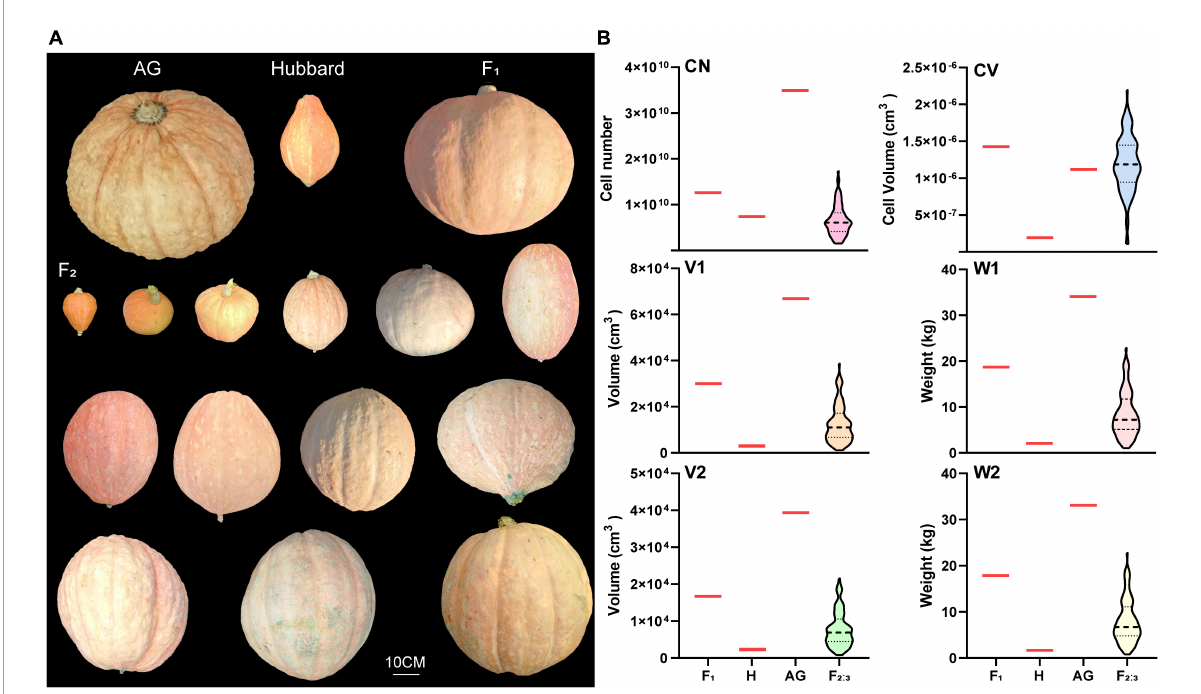
FIGURE1 Fruit phenotypic characterization of two parents “Atlantic Giant” and “Hubbard”, the F 1 hybrid and the F 2 : 3 groups. (A) Fruit morphology. (B) Violin plots of cell number (CN), cell volume (CV), fruit volume (V1), fruit weight (W1), fruit volume without seeds and placenta (V2) and fruit weight without seeds and placenta (W2) of Atlantic Giant (AG), Hubbard (H), F 1 and F 2 group. Black horizontal lines display the median and black dotted lines display 25th and 75th